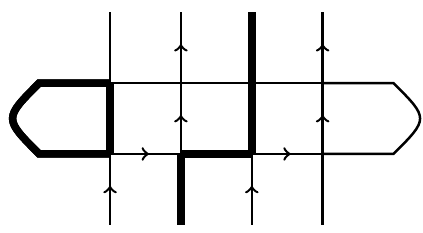
Figure 8 . Two rows of vertices constructed from the transfer matrix. The fact that K becomes diagonal in the appropriate basis implies that the parity of the number of thick lines are conserved. This ensures that there are an even number of vertices that di(cid:11)er by a sign in the D 2 the staggered six-vertex